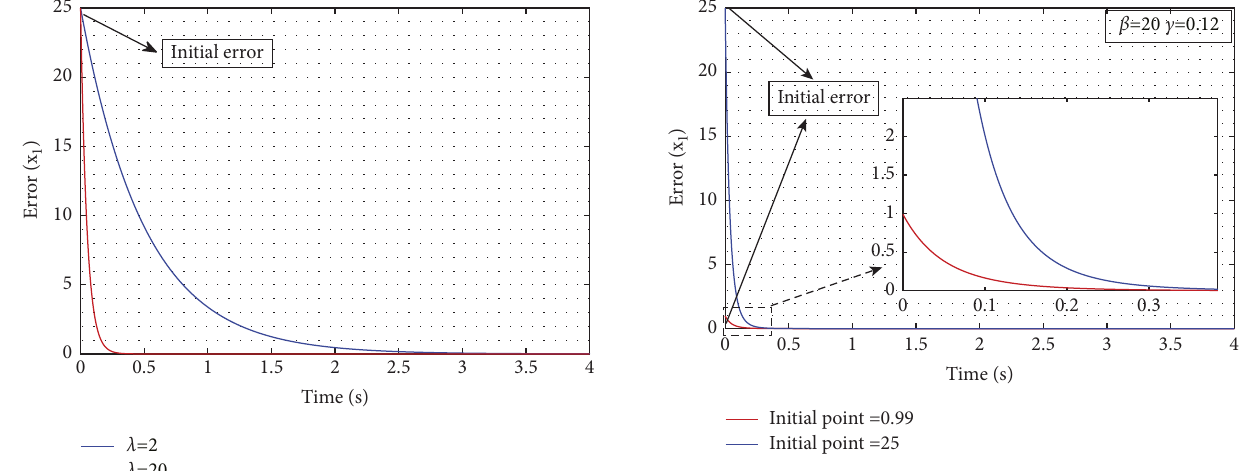
Figure 3: Error trajectory of TSMC with diferent initial values.